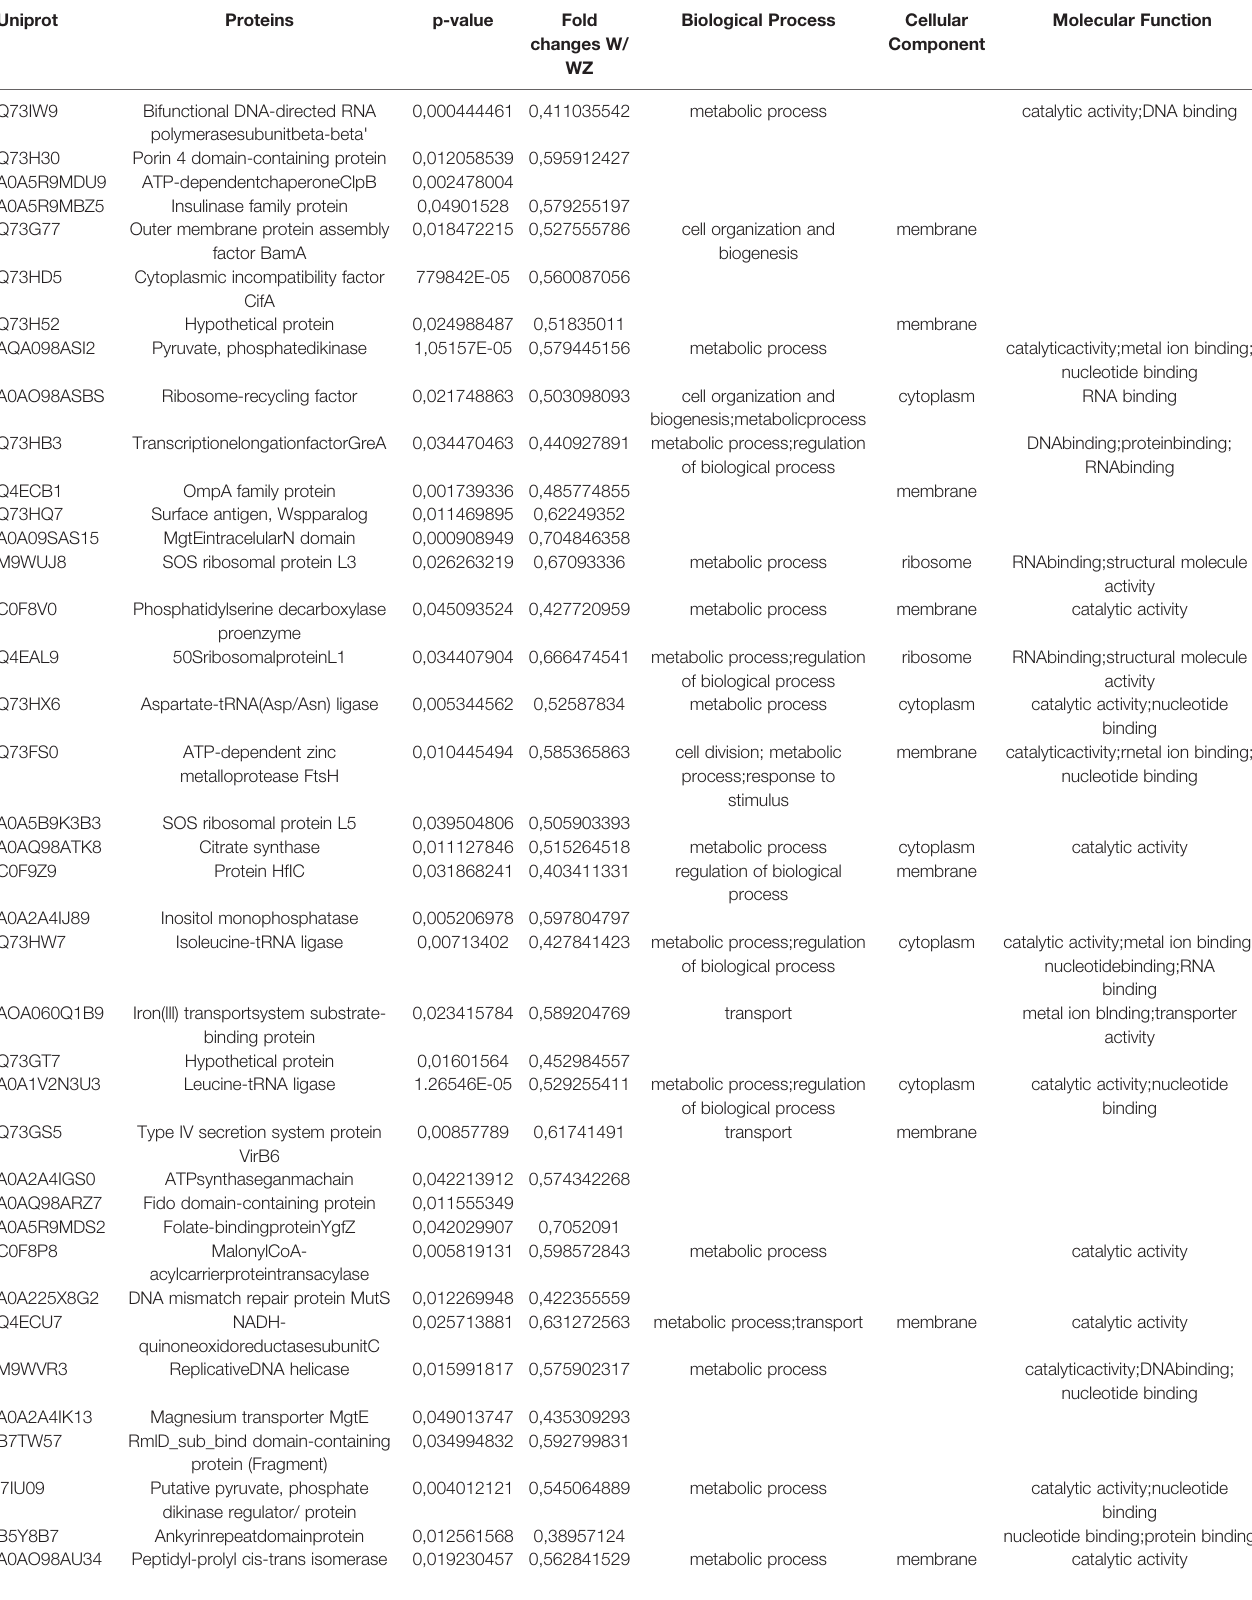
TABLE 1 | Wolbachia proteins with signi fi cant differences in abundance between W and WZ.